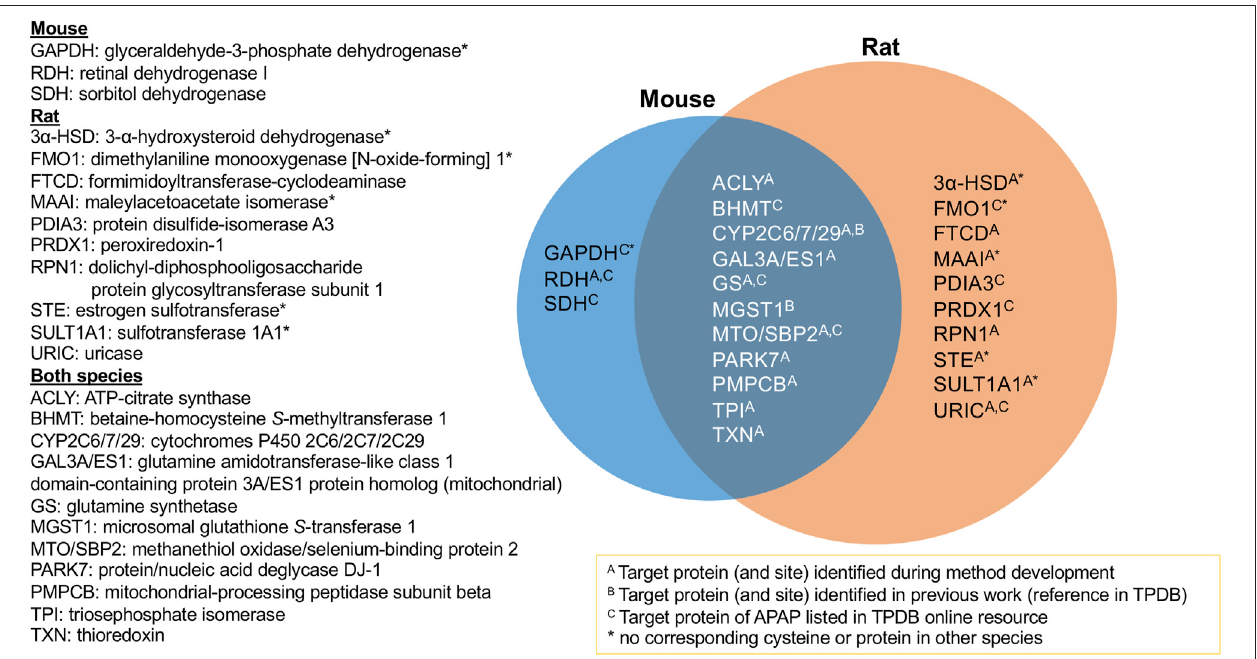
FIGURE 3 | Summary of APAP protein targets con fi rmed in rat and mouse liver samples via targeted LC-MRM analyses.